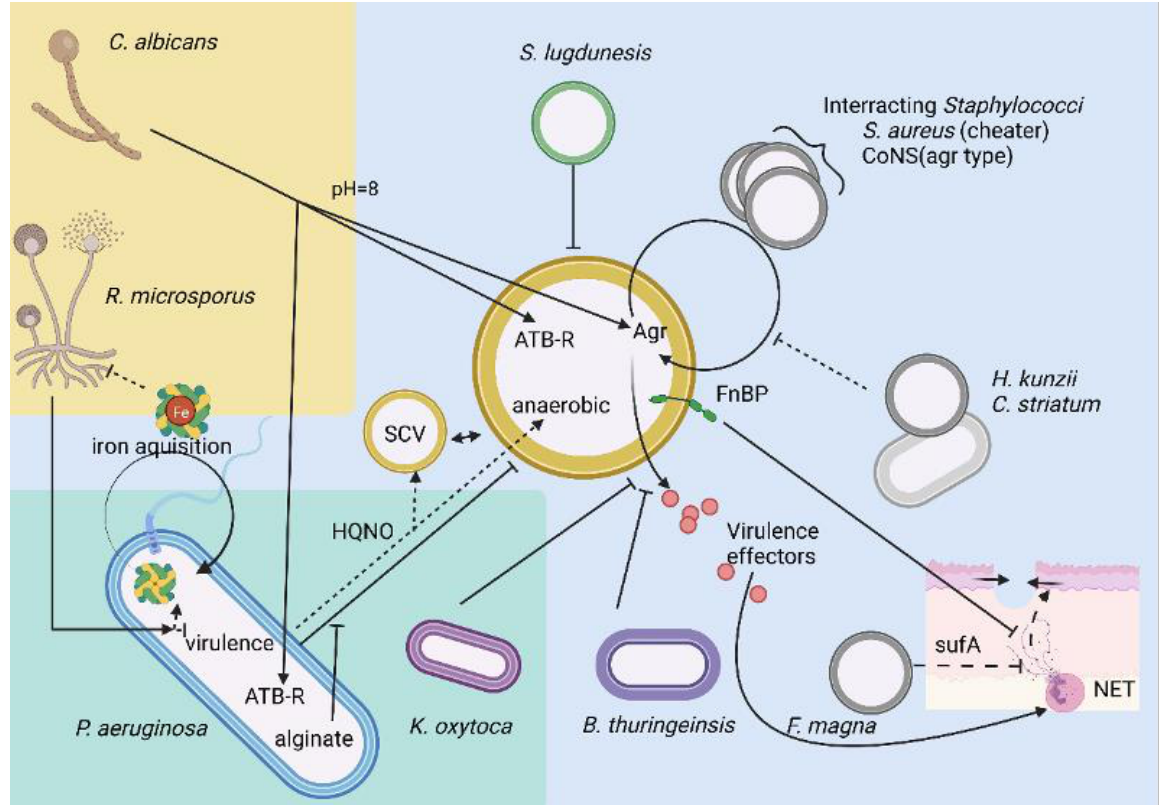
Figure 2. Selected network of interactions described or expected in a chronic wound environment illustrating the diversity involved within this particular niche. Fungi, Gram-negative, and Gram-positive microorganisms are highlighted in yellow, green, and blue, respectively. S. aureus is represented at the center of this network of interaction in yellow. Grey Gram-positive cocci represent Staphylococci ( S. aureus and Coagulase negative Staphylococci (CoNS)). They interact through Agr system by benefiting from S. aureus autoinducers production and/or production of their own autoinducers antagonizing S. aureus Agr loop. Green/yellow helix represents siderophore used for extracellular iron acquisition. It is represented as complexed with Fe 2+ (red core). Solid lines illustrate direct interaction between microorganisms, whereas dashed lines illustrate indirect interaction. Shaded arrows indicate dynamic interaction. Arrows highlight positive interaction, and flathead arrows highlight negative microbial interactions. ATB-R, antibiotic resistance; HQNO, hydroxyquinoline N-oxide (mediator of P. aeruginosa quorum sensing); NET, neutrophils extracellular trap (neutrophils are activated to enter this pathway through S. aureus virulence factors; after releasing bacterial DNA and histone in the extracellular environment, SufA and FnBP can degrade histones and thus inhibit their bactericidal activity). 3.2. S. aureus and P. aeruginosa The most extensively described interaction within the chronic wounds ecosystem is the competition/synergy between S. aureus and P. aeruginosa . Indeed, the virulence of P. aeruginosa can be enhanced by N-acetylglucosamine and peptidoglycan fractions from Gram-positive bacteria [69,103,104]. In parallel, through antagonist interactions, S. aureus is maintained in its persistence/resistance form as a small colony variant (SCV) [105–107] (Figure 2). This interaction alters epithelization, contributing to wound chronicity [108]. SCVs are promoted through an in vitro antagonism, resulting in a clearance of S. aureus ; once transposed in an in vivo context, this SCV-leading interaction induces colonization promotion [109]. One of the antagonisms is driven by the P. aeruginosa quorum-sensing system because hydroxyquinoline N-oxide (HQNO) exposure selects the SCV form [105], decreases the agr system (see Section 3.1 Staphylococci ), and promotes biofilm production [107]. Albumin has also been shown to sequester P. aeruginosa quorum-sensing molecules and thus prevent S. aureus killing [74,110]. Finally, this competition partially depleting the